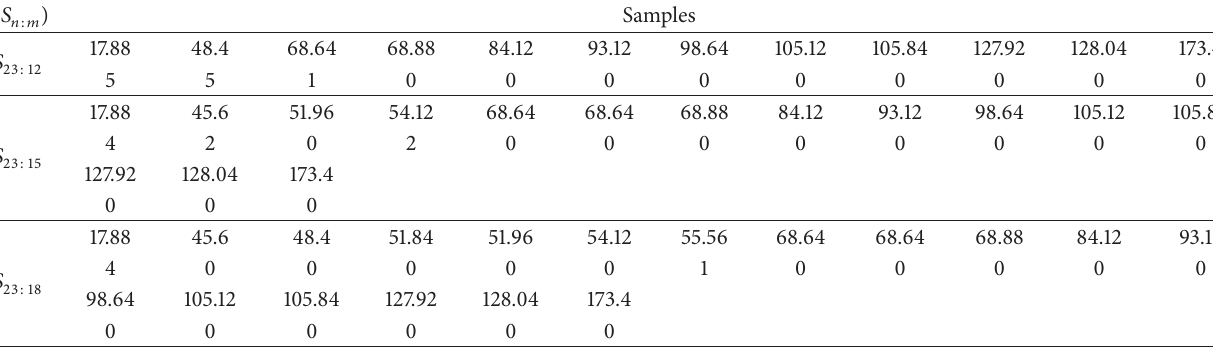
Table 6: PT-II CBR under different censoring scheme ( 𝑆 𝑛:𝑚 ) for fixed 𝑛 = 23 , 𝑝 = 0.5